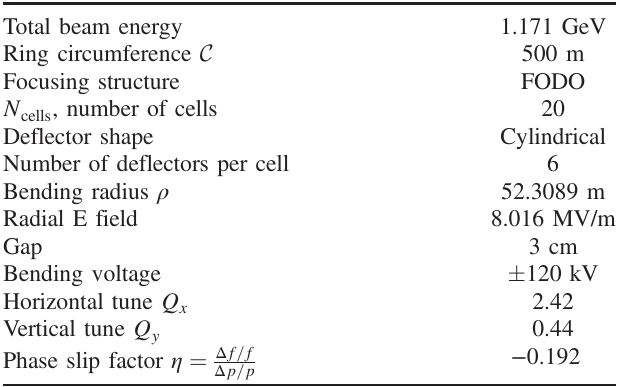
I. Table of the ring parameters of the proton EDM experiment. Note that, for protons, G ¼ 1 . 7928474